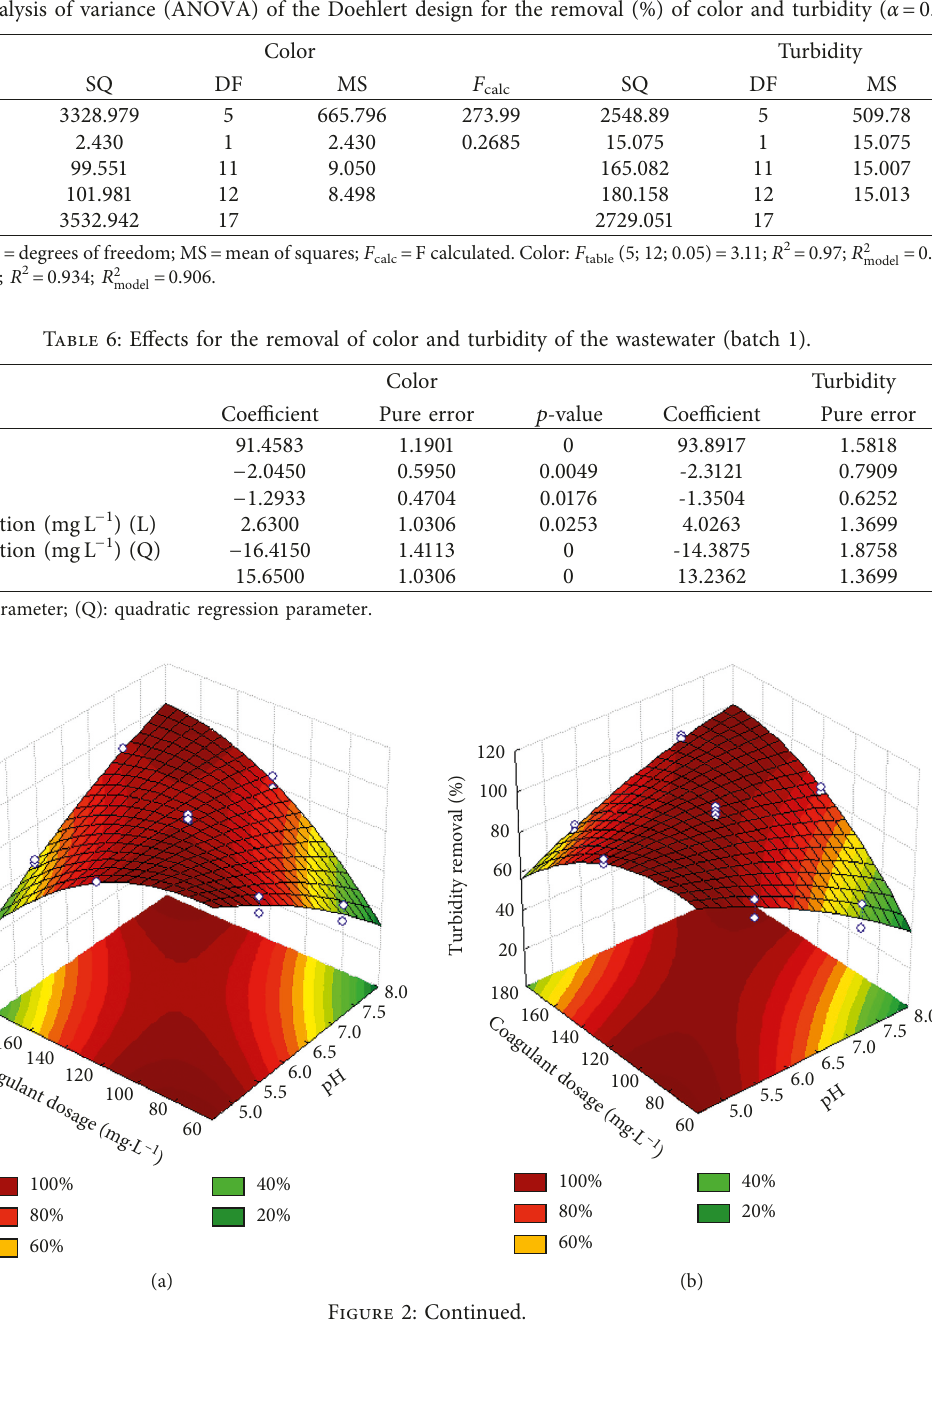
Table 5: Analysis of variance (ANOVA) of the Doehlert design for the removal (%) of color and turbidity ( α Source of variation